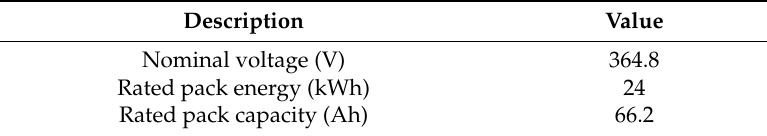
Table 3. Main characteristics of the electric vehicle